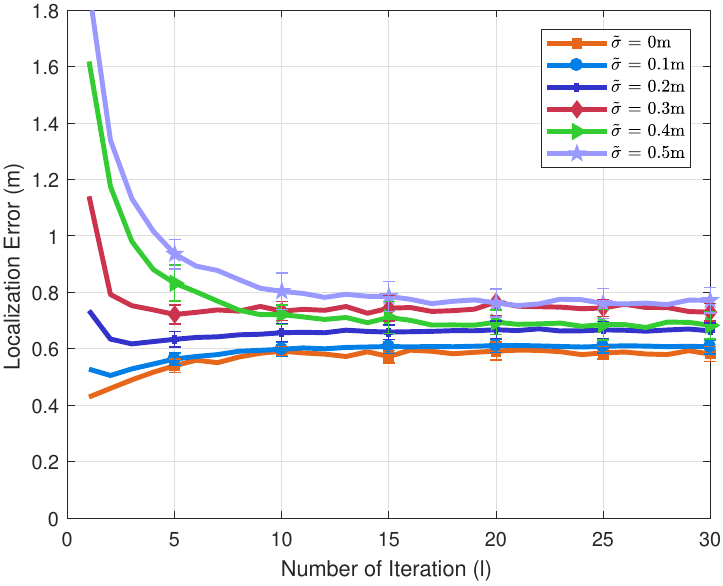
Figure 9. Average errors of 10 vehicles with respect to ˜ σ